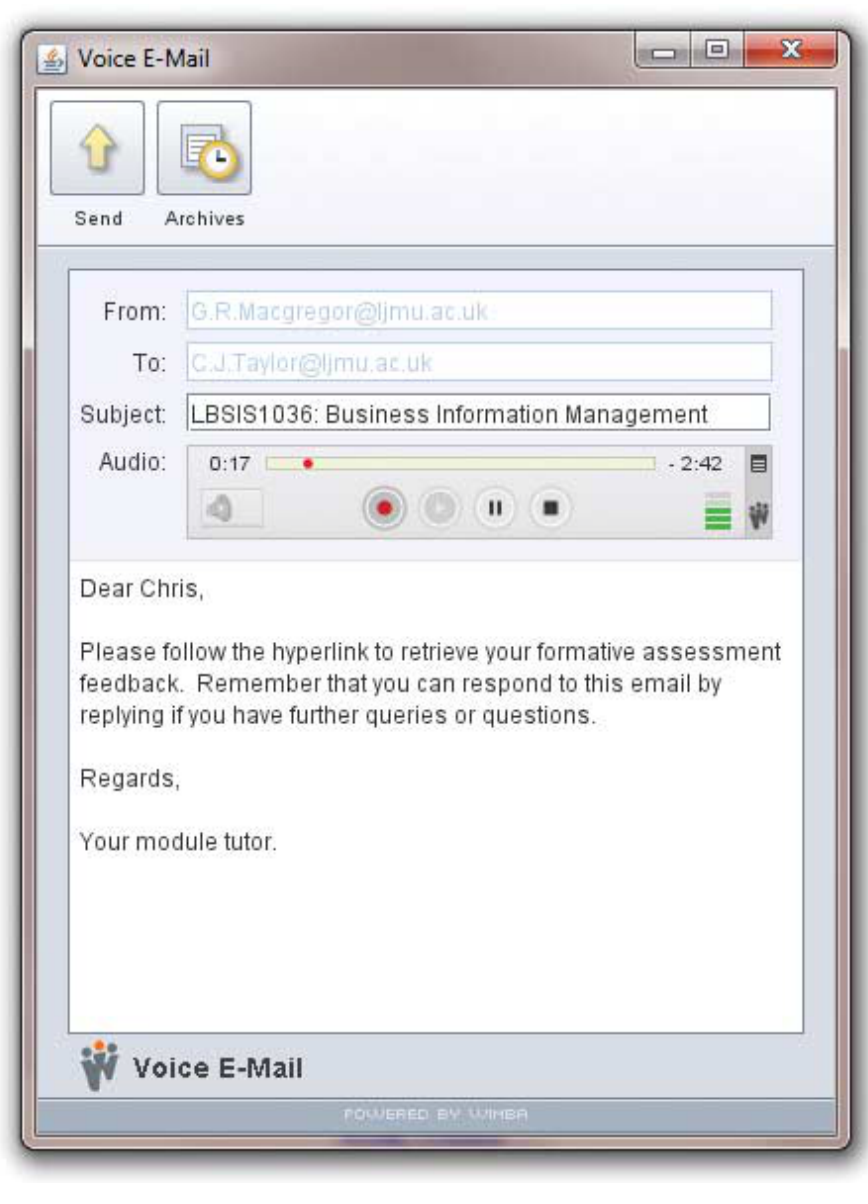
Figure 1. Creating a ‘voice email’ using Wimba